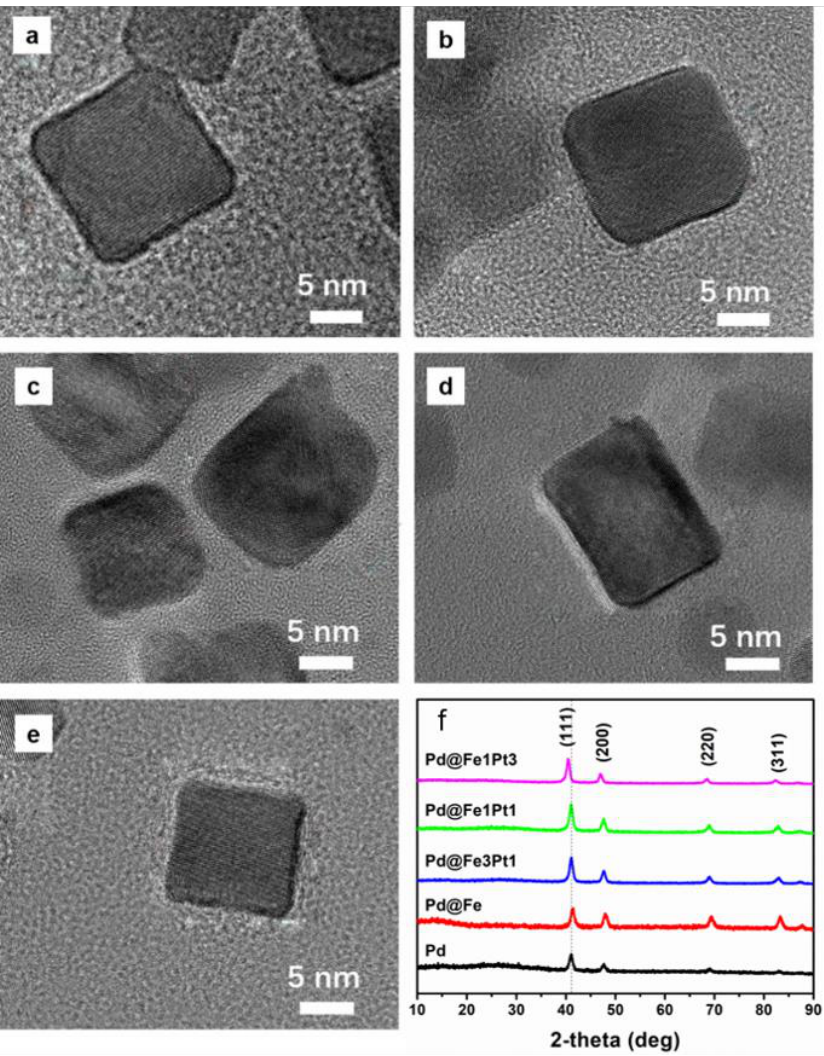
Figure 1. High-resolution TEM ( HRTEM) images of ( a ) Pd, ( b ) Pd@Fe, ( c ) Pd@FePt 3/1 , ( d ) Pd@FePt 1/1 , and ( e ) Pd@FePt 1/3 core–shell nanoparticles. ( f ) XRD patterns of the